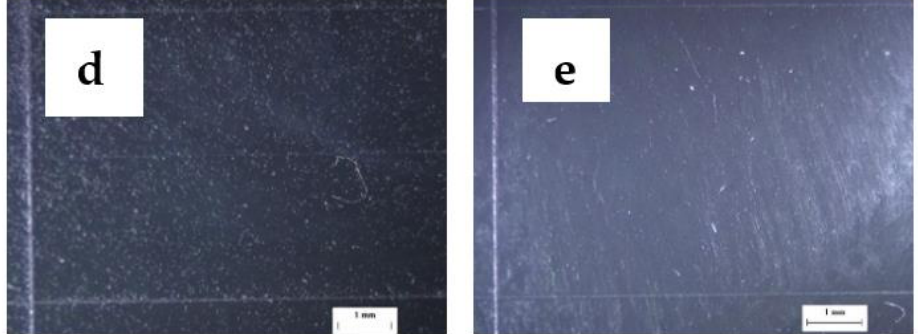
Figure 3. Surface detail reproduction for commercial and Exp VPS (medium-bodied) impression materials under moist conditions, where (d) Exp-I and (e) Exp-II. The scale bar is 1 mm.